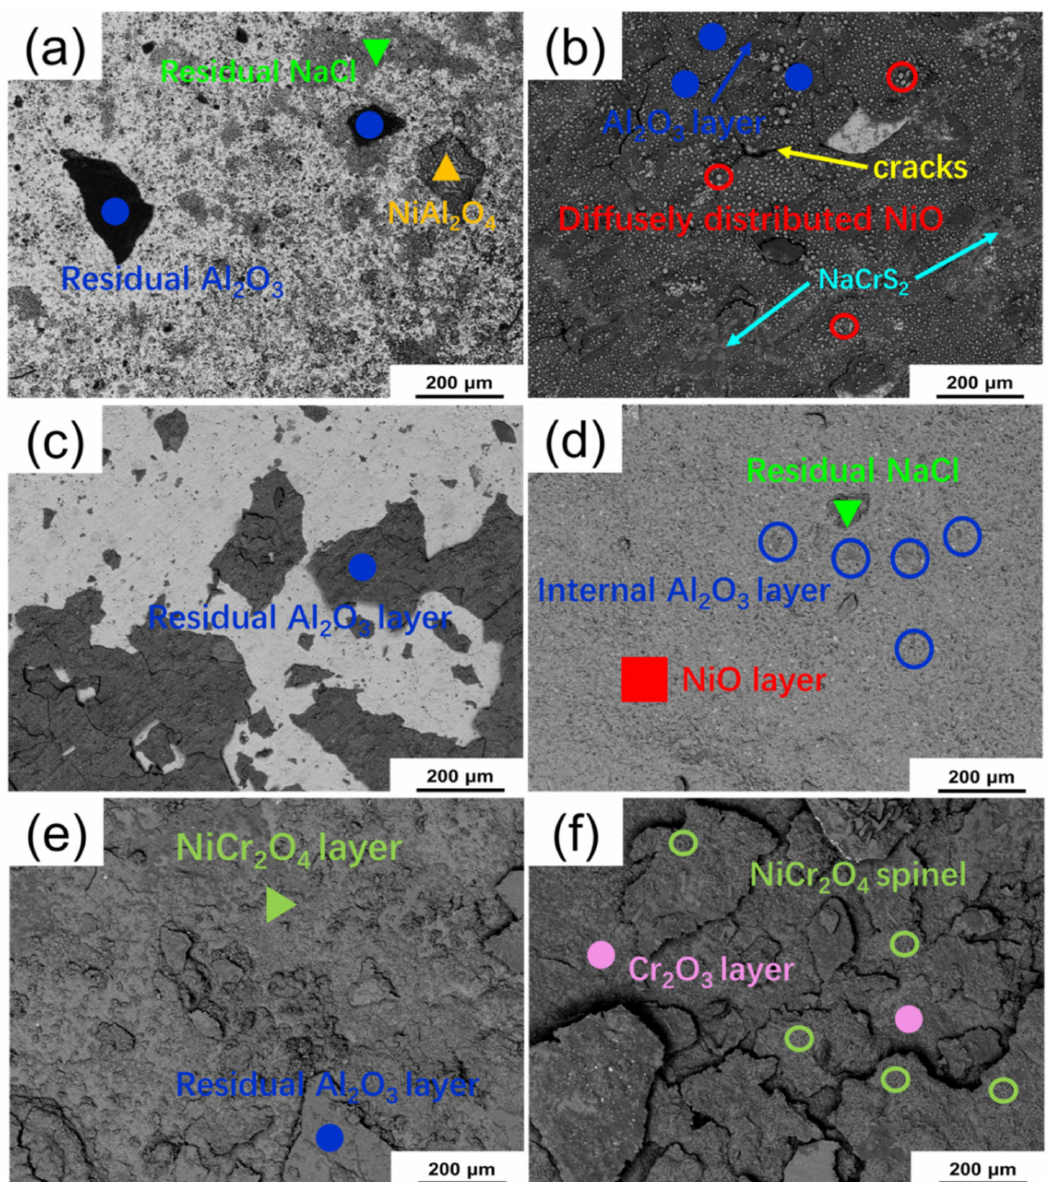
Figure 6. The surface morphologies (BSE images) of sealed and unsealed samples of three alloys corroded at 900 ◦ C for 200 h: sealed samples: ( a ) Alloy 1, ( b ) Alloy 2 and ( c ) Alloy 3; unsealed samples: ( d ) Alloy 1, ( e ) Alloy 2 and ( f ) Alloy